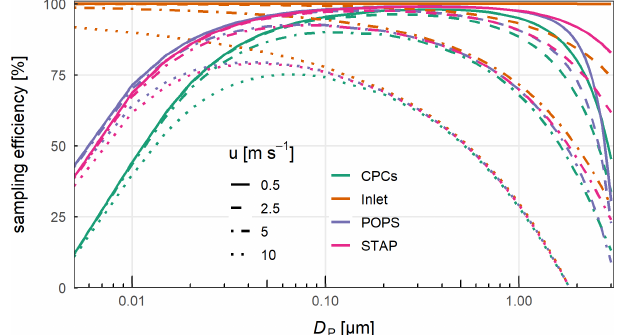
Figure 6. Sampling efficiency of the funnel inlet alone and the sam- pling lines to the individual instruments, including losses due to diffusion, gravitational settling, impaction, and at the inlet. Calcu- lations are based on sampling line geometry and the flow specifics of each instrument (Fig. S1) as a function of particle diameter ( D P ) and ambient wind speed ( u